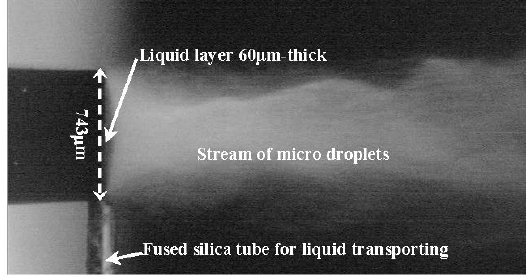
Figure 7. Droplet ejection from a 60 µ m-water layer on the end face (743 µ m × 800 µ m) of a 2.0 MHz 4-Fourier horn nozzle at 200 µ L/min output rate and 0.15 W electrical drive